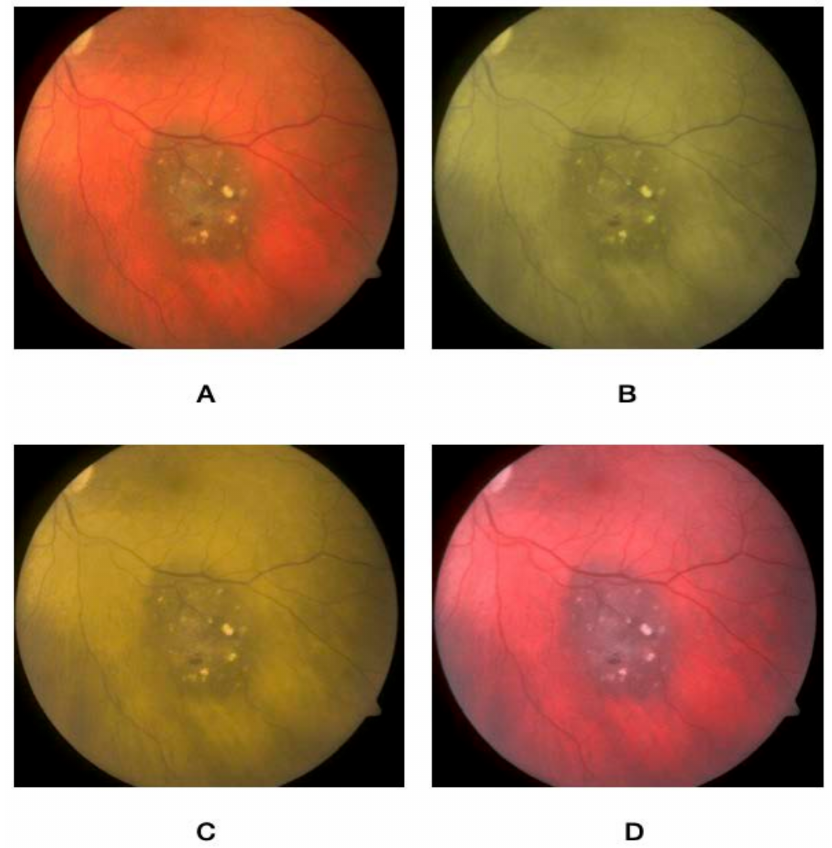
Figure 5. Fundus images for choroidal nevus ( A ), under simulated protanopia ( B ), deuteranopia ( C ), and tritanopia ( D